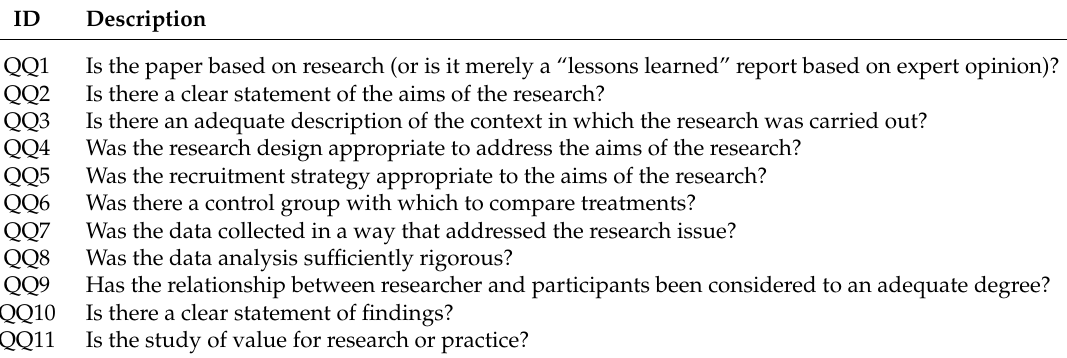
Table 6. Quality questions used in this review